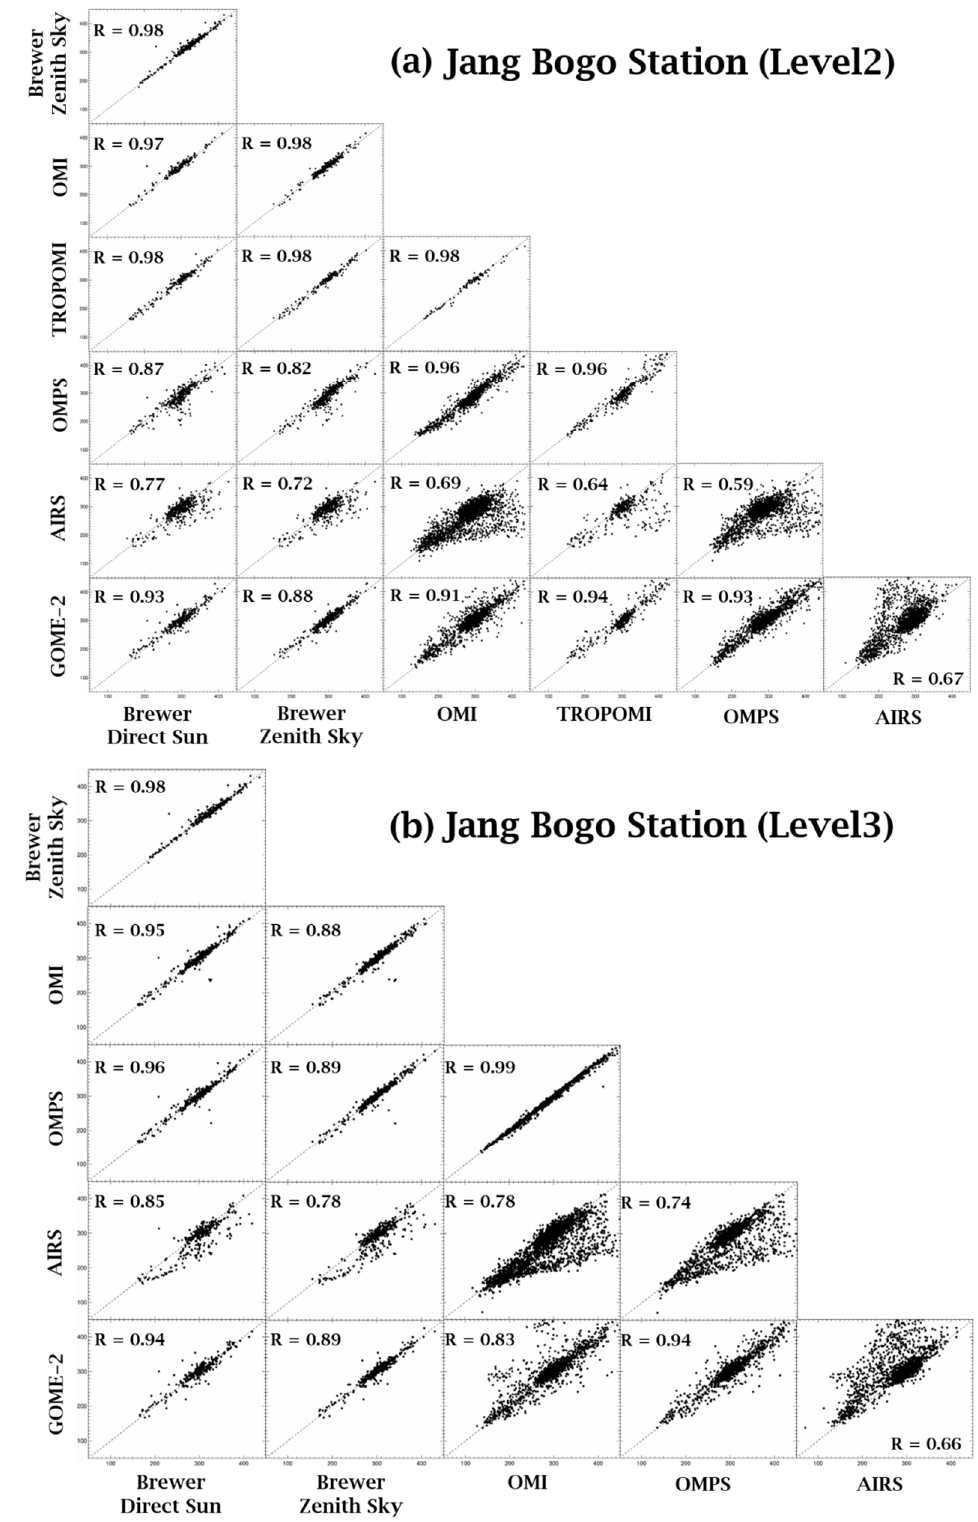
Figure 4. Scatterplots for the TOC comparison between satellite measurements and the Brewer measurements at the Jang Bogo station: (a) Level 2; and (b) Level 3 TOC comparisons.